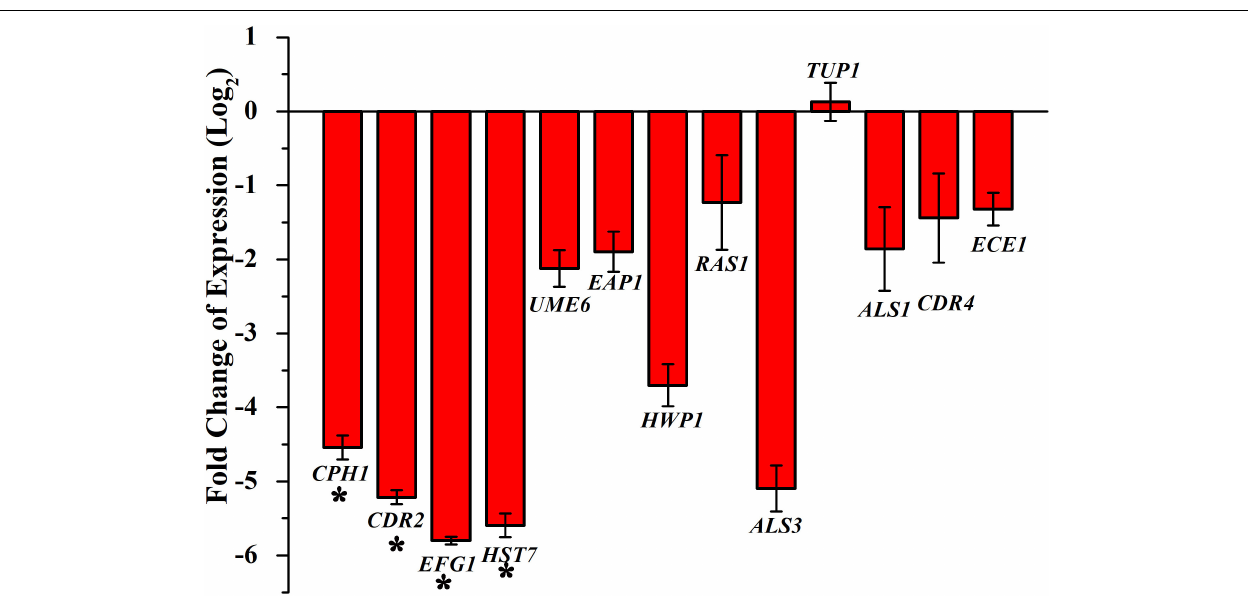
FIGURE 8 | Differential regulation of genes involved in biofilm and hyphal development of C. albicans by piperine at BIC (32 µ g mL - 1 ). Filamentation-promoting genes, such as CPH1 , UME6 , and EFG1 ; hyphal growth-extending genes, such as EAP1 , HWP1 , HST7 , RAS1 , and ECE1 ; adhesion-supporting ALS3 and ALS1 ; and drug resistance genes CDR4 and CDR2 are significantly downregulated by piperine. tup1, transcriptional repressor for the filamentation and hyphae-inducing genes, is upregulated. Error bars represent standard deviations from the mean ( n = 3). * p <